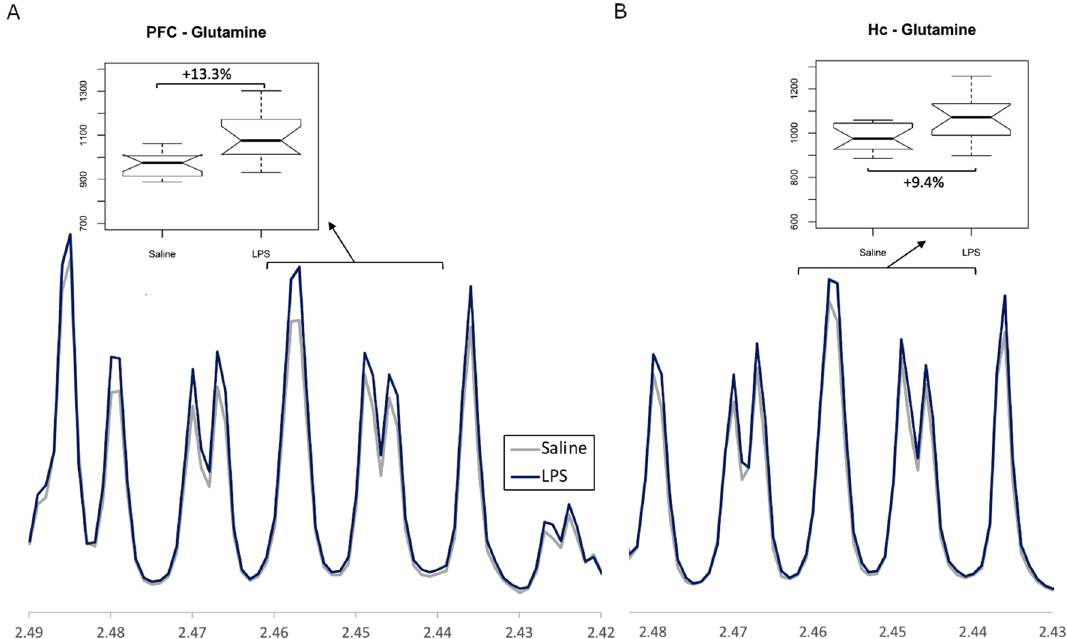
Figure 7. Representative images of NMR spectra showing group differences between a glutamine bin in ( A ) prefrontal cortex tissue (PFC) and ( B ) Hippocampal tissue (Hc). Spectra expressed as average of treatment